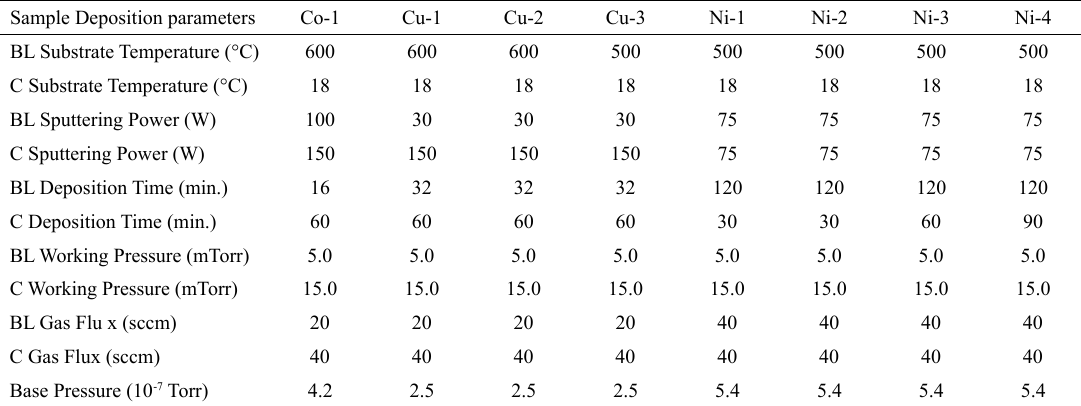
Table 2. Parameters used in the samples